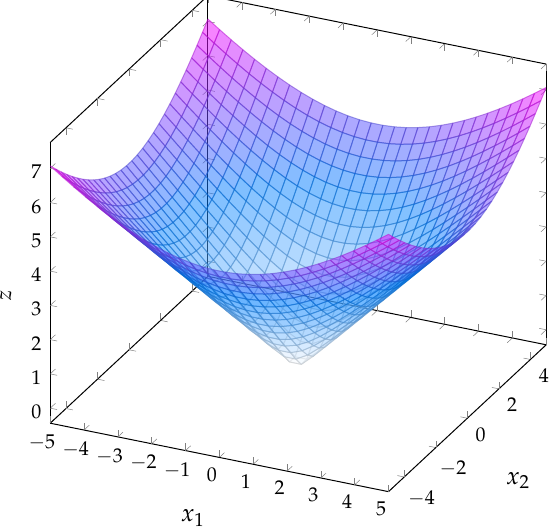
Figure 2. Representation of the second order cone Ω = {(cid:107) x (cid:107) ≤ z } . with x ∈ R 2 and z ∈ R